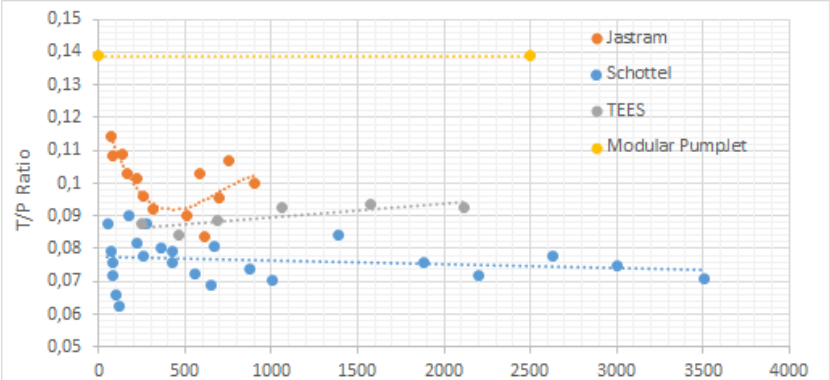
Figure 26. The comparison between PJM estimation and the existing